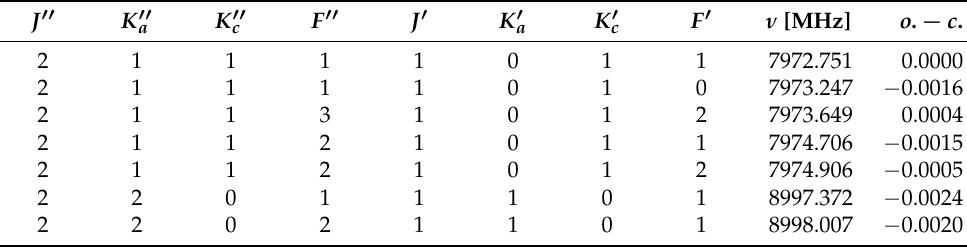
Table A2. Experimental µ c -type transition lines of DEHA · H 2